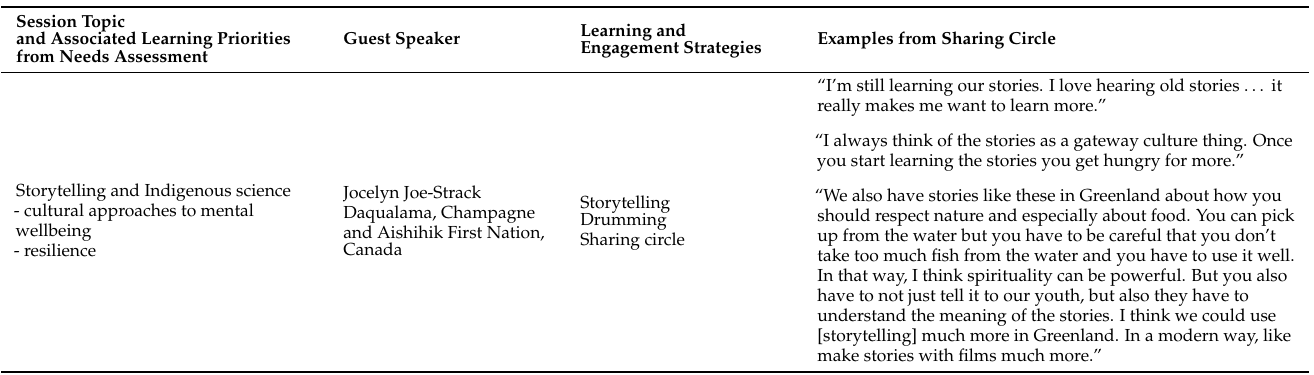
Table 3. Session and speaker